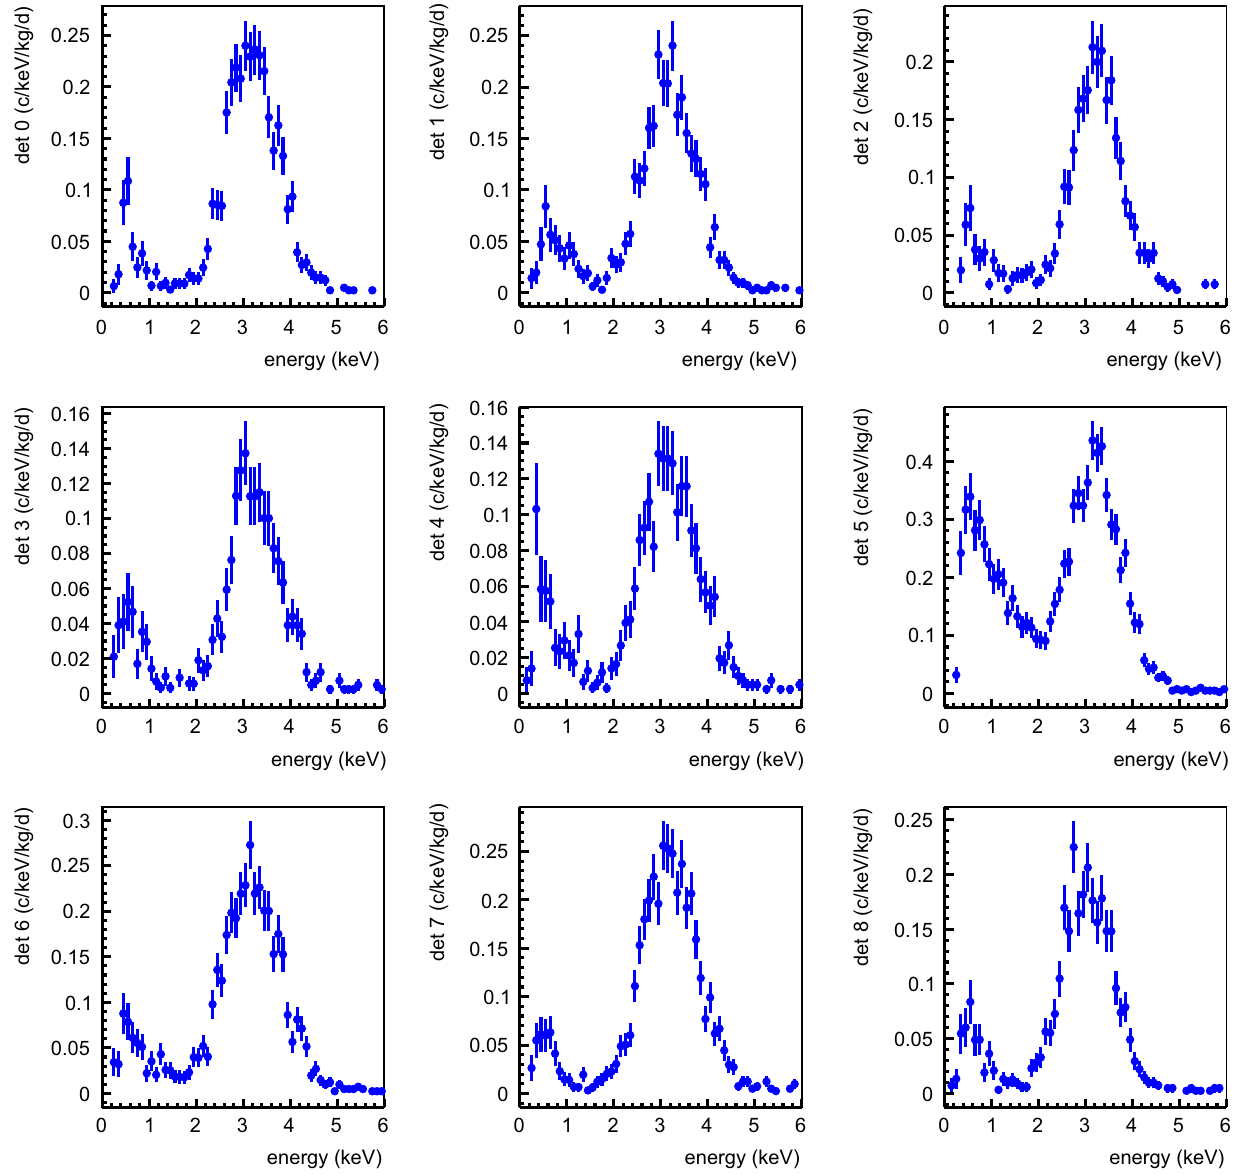
Fig. 2 Low energy spectra of events in coincidence with a 1460.8 keV gamma (in a ± 1 . 4 σ window) in another module used to assess the 40 K activity in each crystal by quantifying the 3.2 keV emissions. They were obtained with the ANAIS-112 set-up for all the detectors during